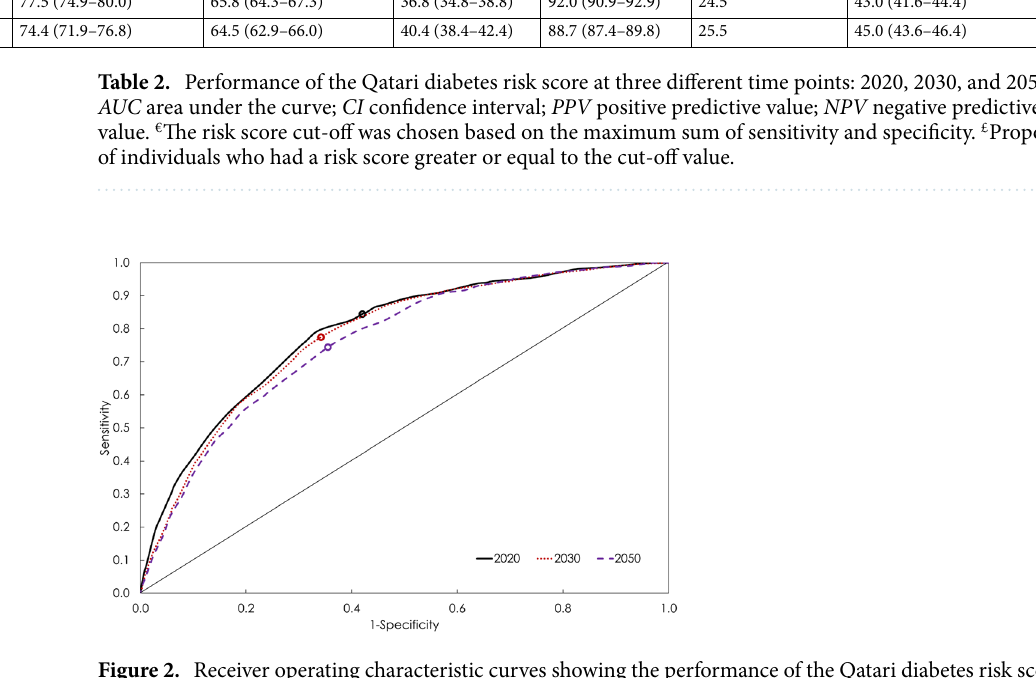
Figure 2. Receiver operating characteristic curves showing the performance of the Qatari diabetes risk score in diagnosing diabetes mellitus among Qataris at three time points: 2020, 2030, and 2050. The area under the curve (AUC) was 0.79 for the 2020 risk score, 0.78, for the 2030 risk score, and 0.76 for the 2050 risk score.